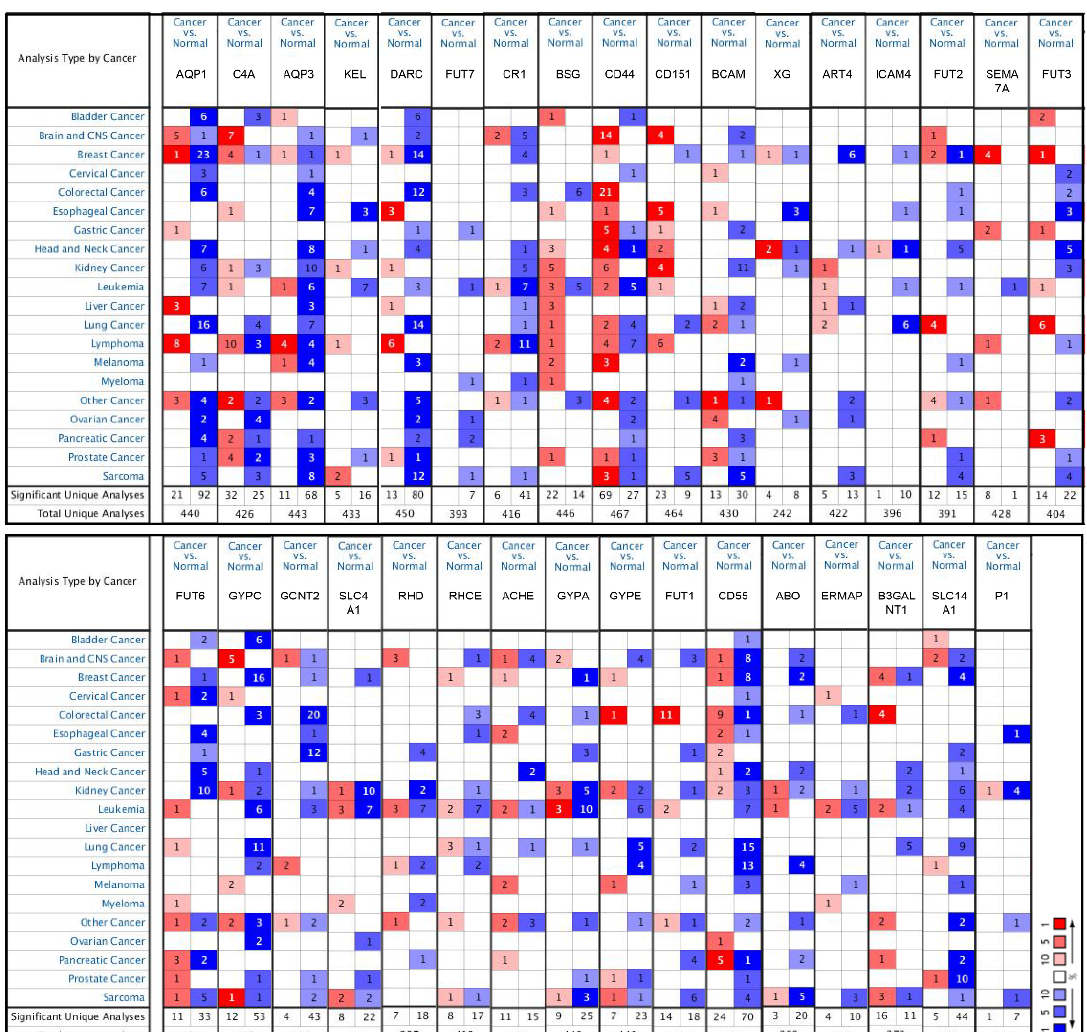
Figure 2. The differential expression of the blood group antigen system gene mRNA expression in pan-cancers. The threshold was set using following parameters: |log2(fold change) | ≥ 1 and p value < 0.05. The number in the cell represents the number of datasets that meets the thresholds. The color intensity (red or blue) is directly proportional to the significance level of upregulation or downregulation, respectively.